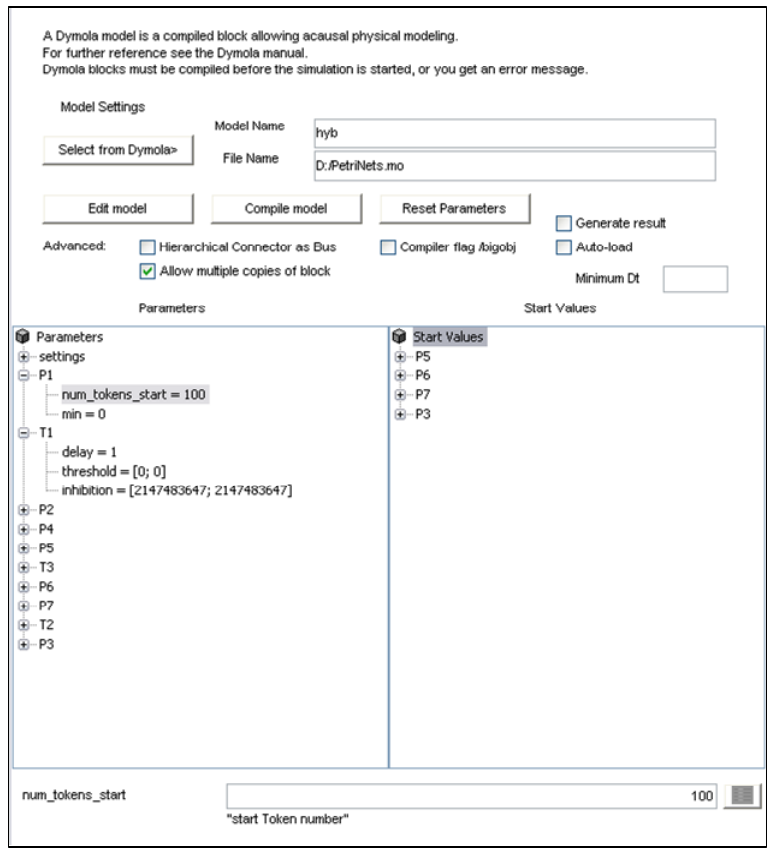
Figure 22: Property dialog of the DymolaBlock in